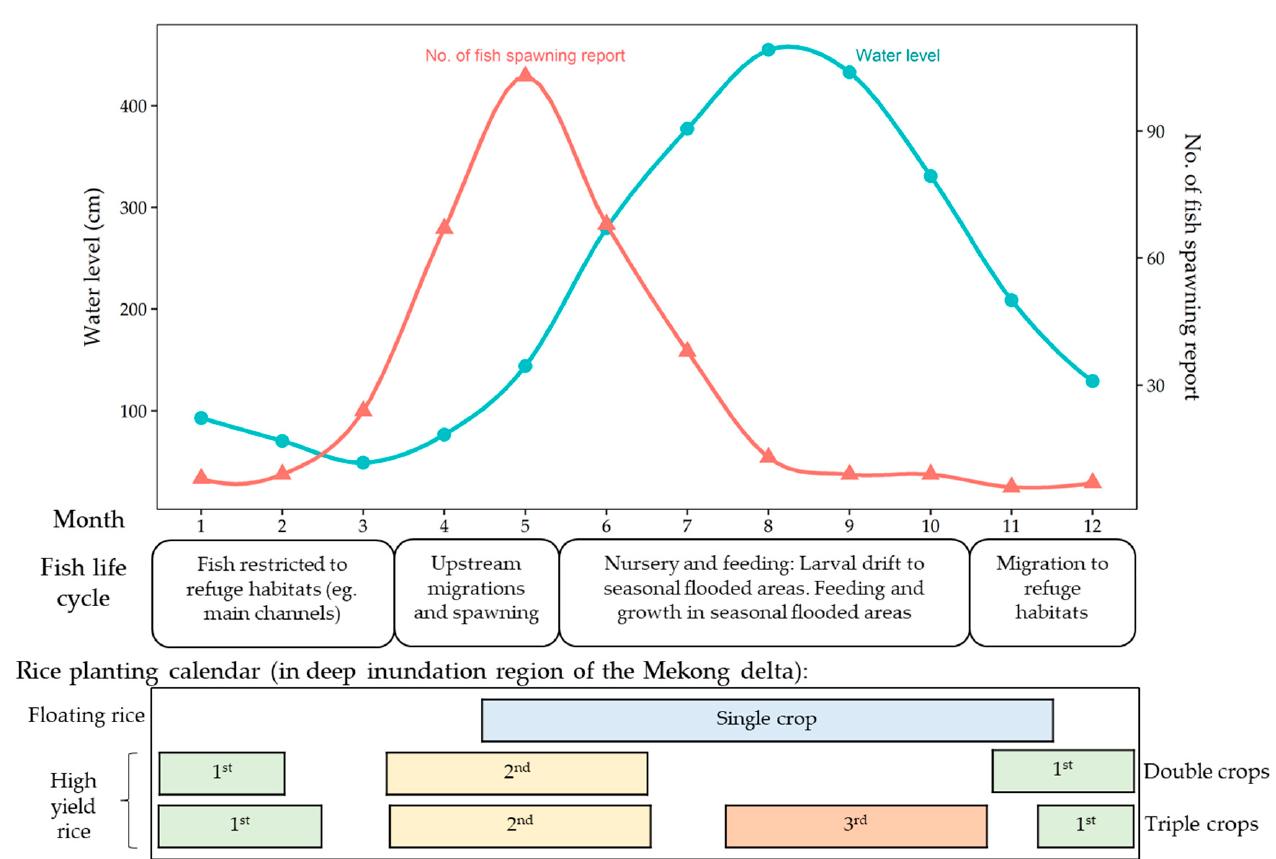
Figure 1. Fish spawning in relation to flooding regimes and rice planting calendar in the Mekong Delta. Fish spawning data from [14] ; water levels measured at Chau Doc station in 2000; fish life cycle adopted from [11] ; rice planting calendar from [15,16]. Floating rice with low yield (2 tonnes/ha/crop and long farming period (6 months) while high yield rice with higher yield (8 tonnes/ha/crop) and shorter farming period (3 months) [15] .